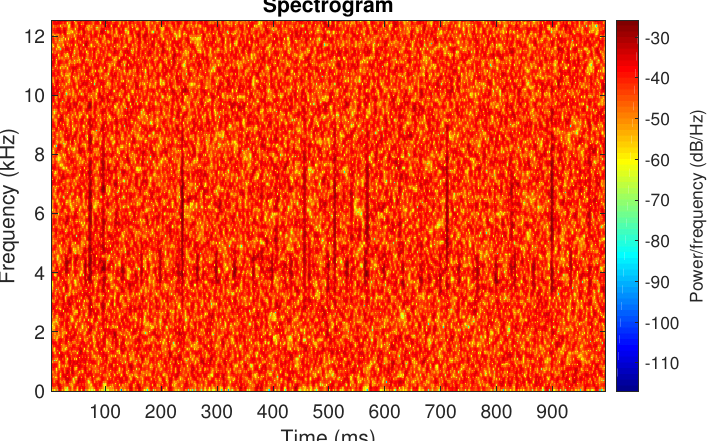
Figure 21. Spectrogram of the simulated signal s 3 .